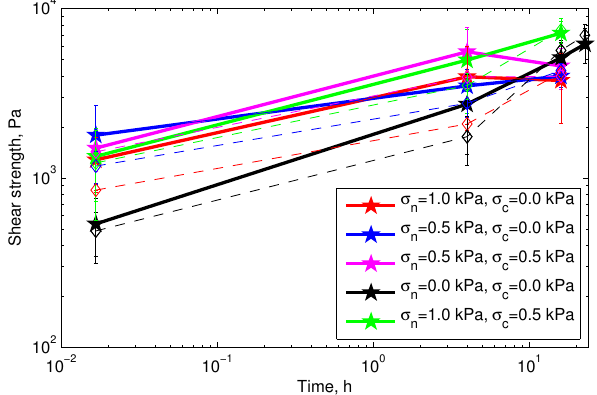
Figure 3. Mean shear strength evolution with sintering time for each set of loading conditions (thick lines indicate all tests; dashed lines – filtered